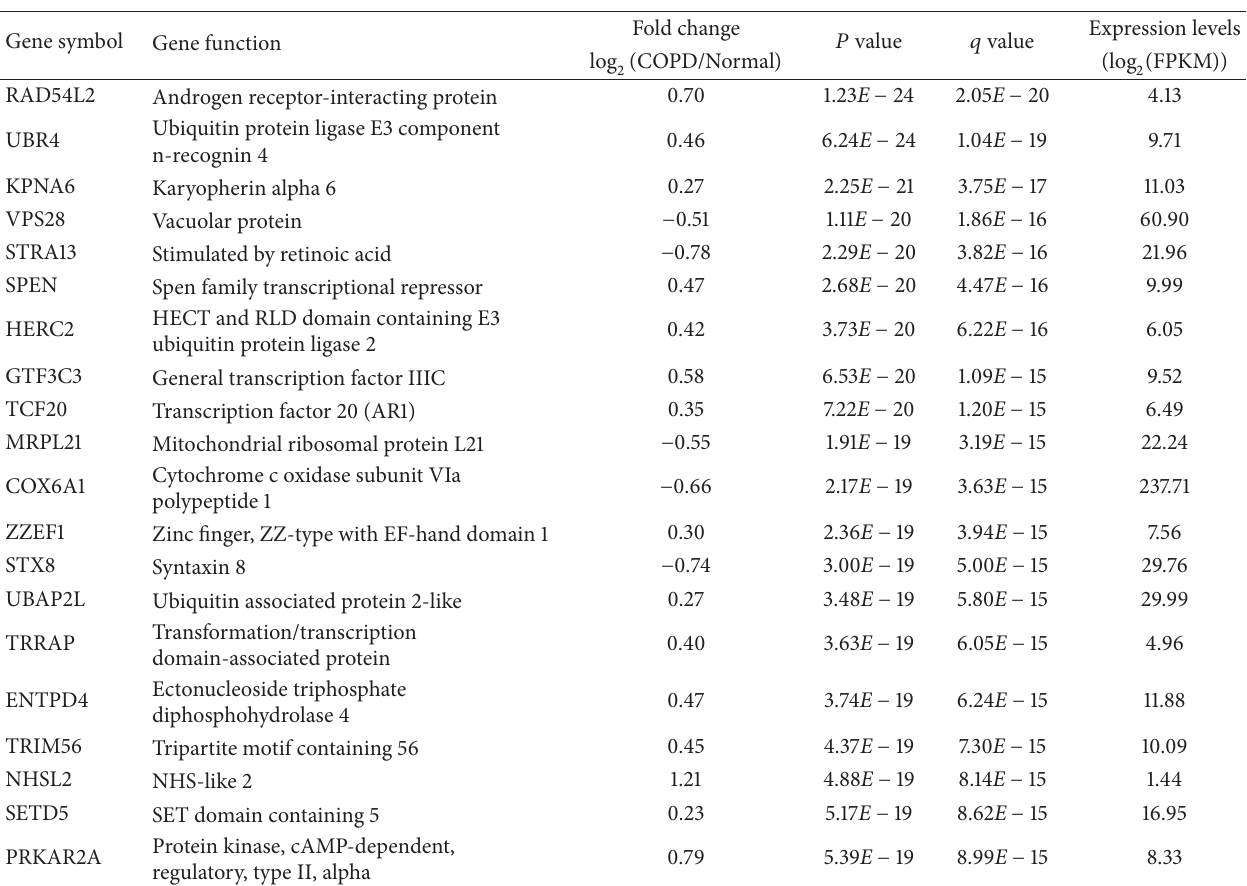
Table 3: Top 20 genes differentially expressed between COPD subjects and subjects with normal lung